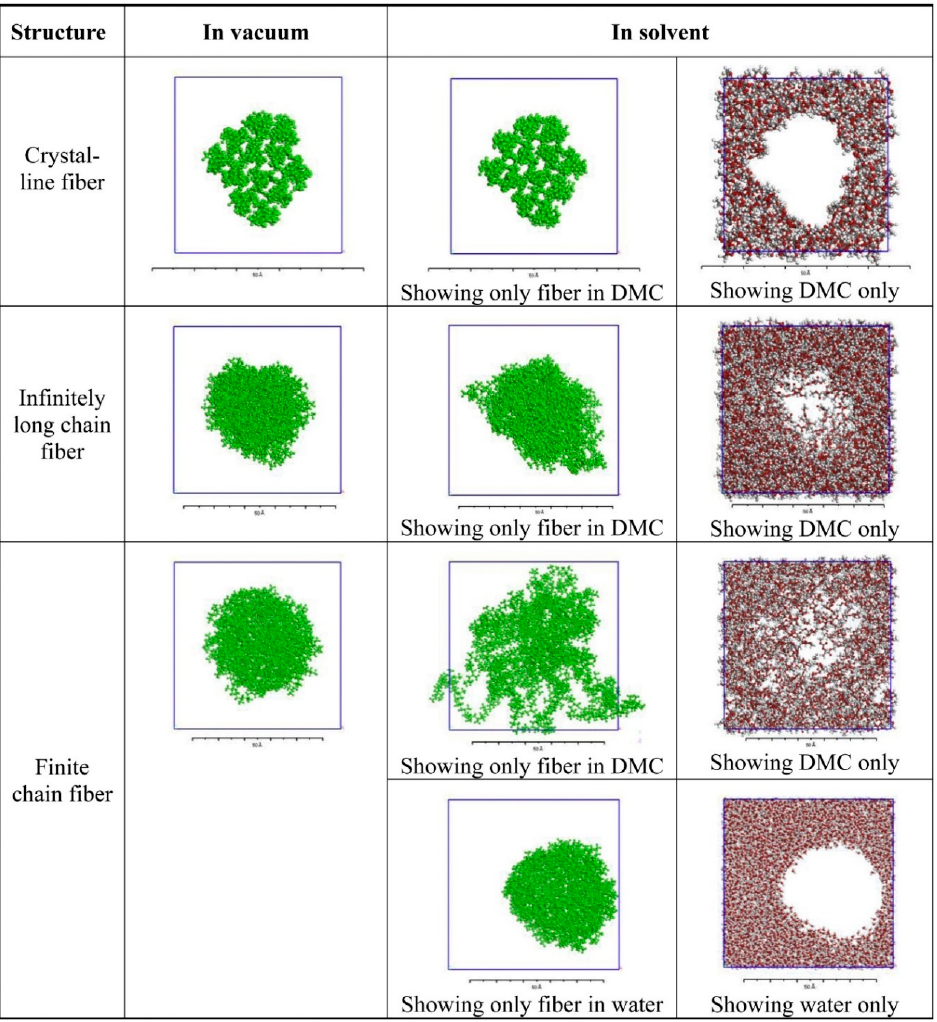
Figure 5. Relaxed structure for crystalline fibre, infinitely long chain fibre and finite chain fibre in vacuum, in DMC, and in water at zero strain [43].